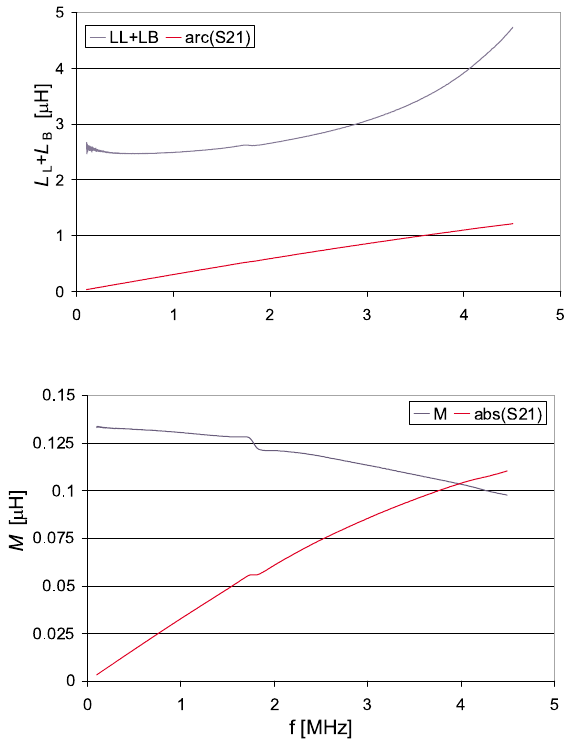
FIG. 9. (Color) Mutual inductance from the busbar to the TW- line scattering